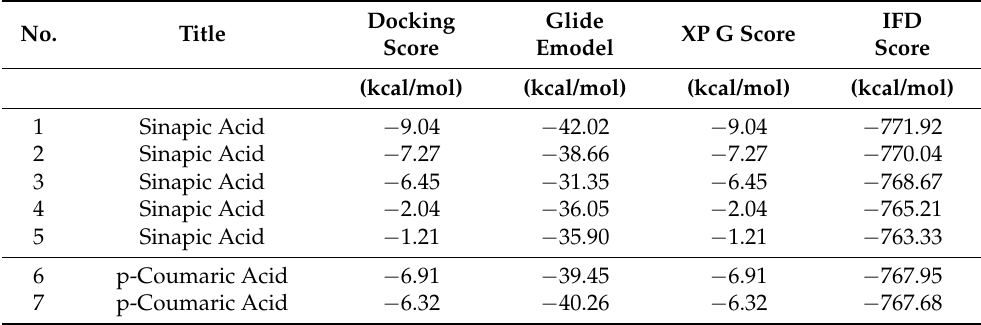
Table 1. Molecular docking energetics for sinapic acid, p-coumaric acid and ciprofloxacin after binding with